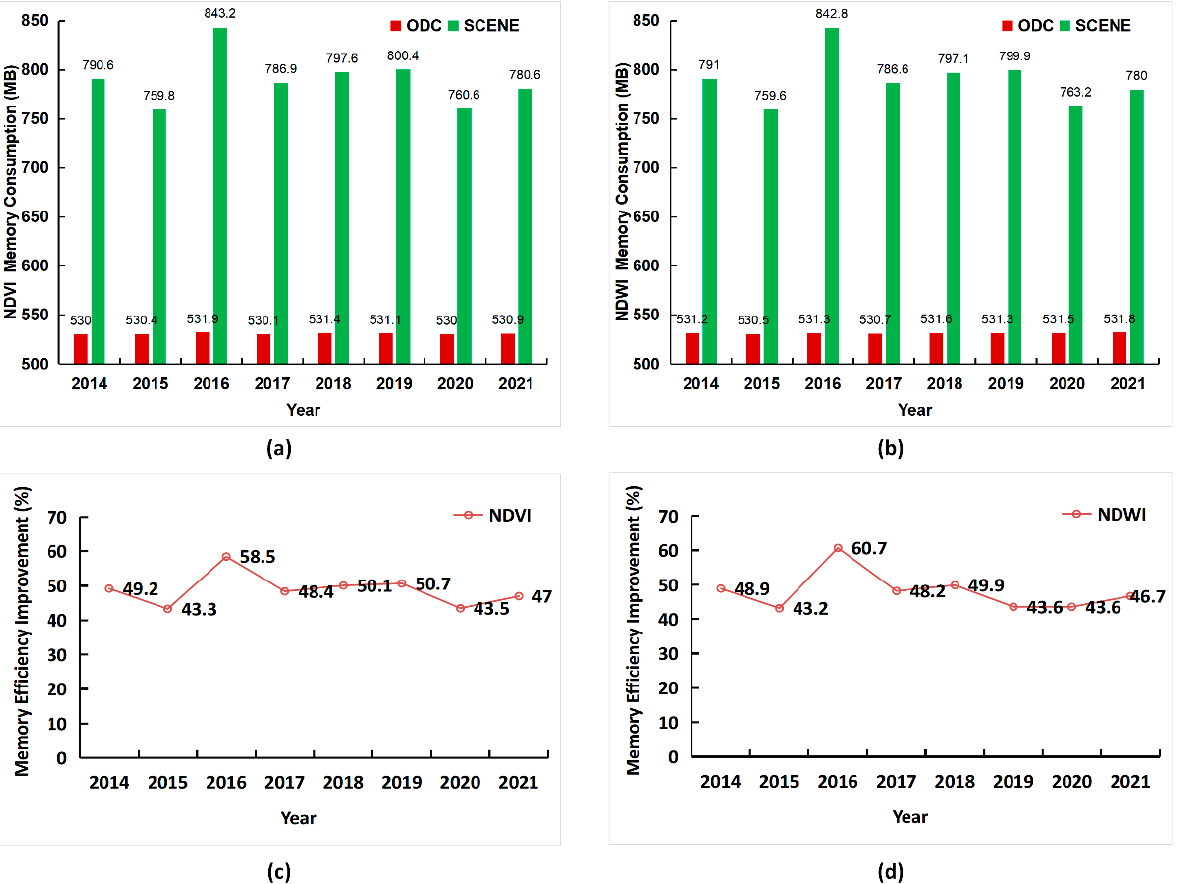
Figure 6. Memory consumption and memory efficiency improvement of the scene-based and ODC grid-based approaches. ( a ) NDVI calculating memory consumption (MB) based on ODC grid-based approaches (red bars) and scene-based approaches (green bars). ( b ) NDWI calculating memory consumption (MB) based on ODC grid-based approaches (red bars) and scene-based approaches (green bars). ( c , d ) Memory efficiency improvement percentage (%) of the ODC grid-based approach over the scene-based approach for calculating NDVI and NDWI, respectively.